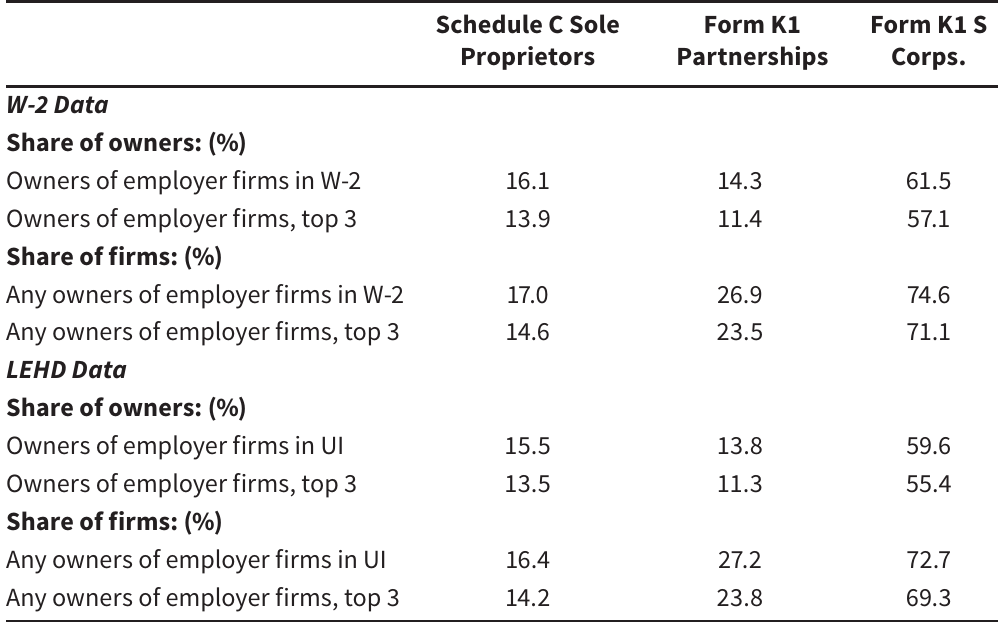
Table C2 Share of owners who receive wage & salary payments: first year, single establishment Schedule C